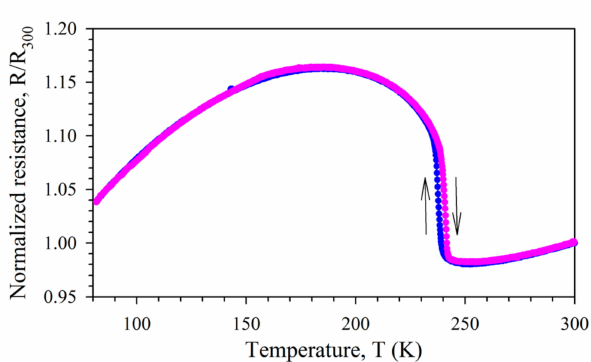
Figure 1. Temperature dependence of resistance for the water-quenched Ti 50 Ni 46.1 Fe 3.9 sample on cooling (blue) and heating (pink). Data are normalized to the resistance values at 300 K.